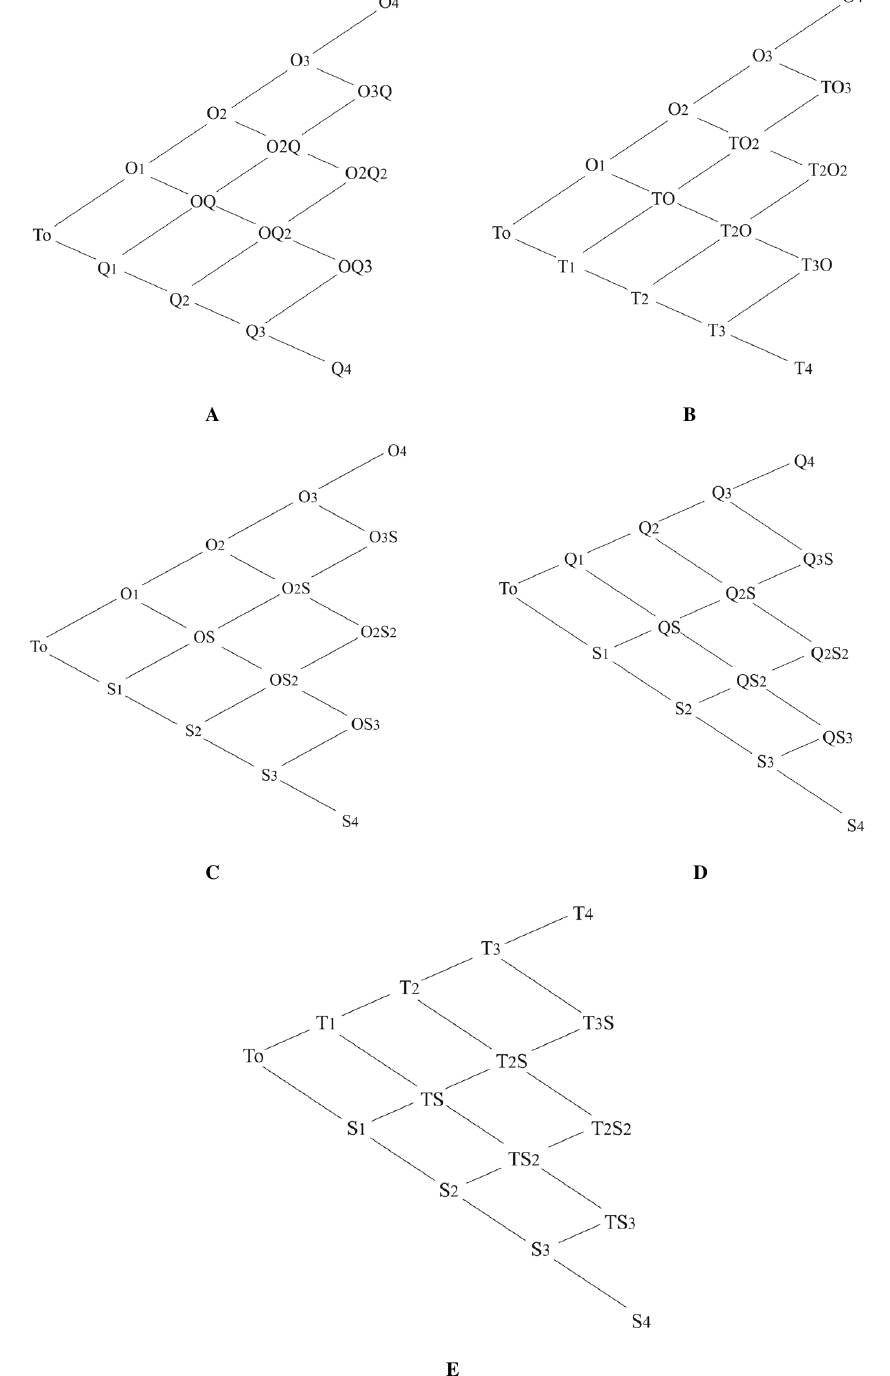
FIGURE 8 . (A) The octave-fifth tone tissue. (B) The octave-third tone tissue. (C–E) The seventh’s tone